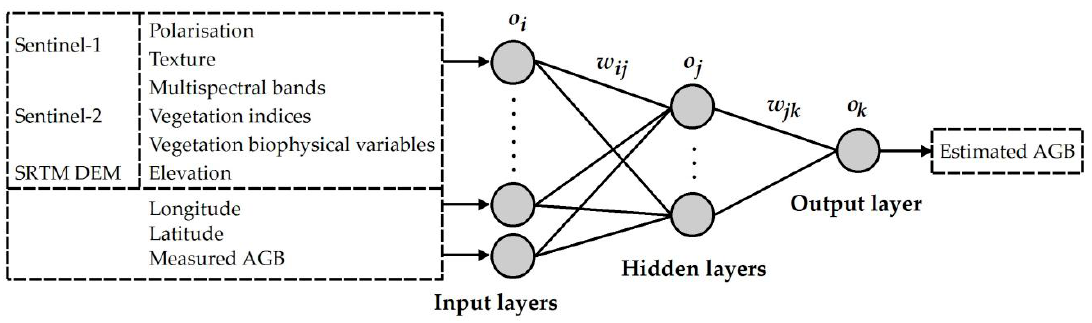
Figure 3. Schematic representation of an example multi-layer perception neural network (MLPNN) model structure to predict forest above-ground biomass. Shown are the inputs with their neurons o i , and interlinked connections from each input to all hidden layer neurons o j , along with the selected weightings. The weighted outputs were then merged and fed into the output neuron o k to form the output values.